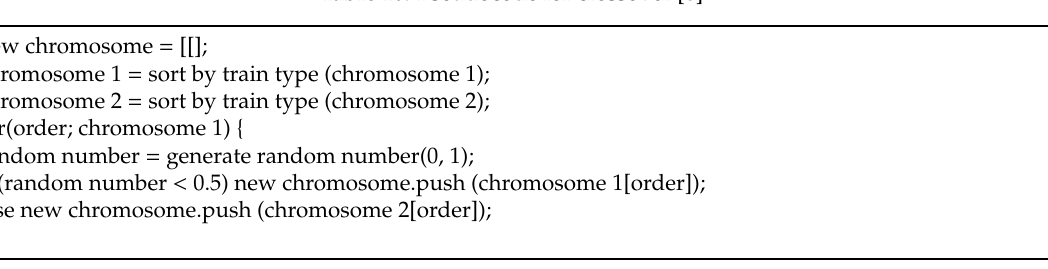
Table 10. Pseudocode for crossover [6].